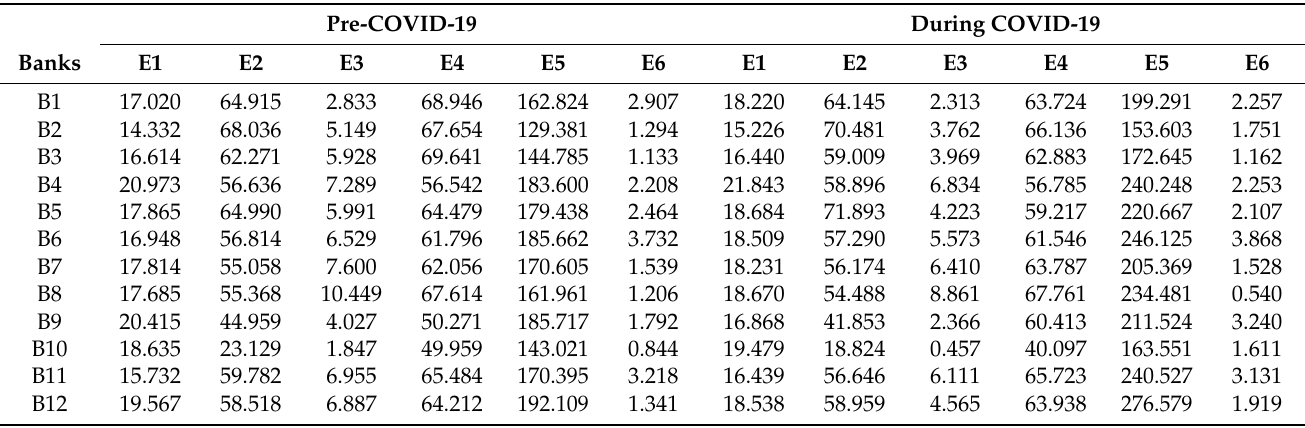
Table 4. The efficiency criteria values of banks pre- and during